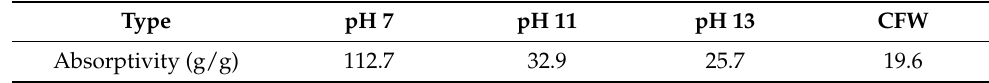
Table 3. Water absorptivity of the SAP.